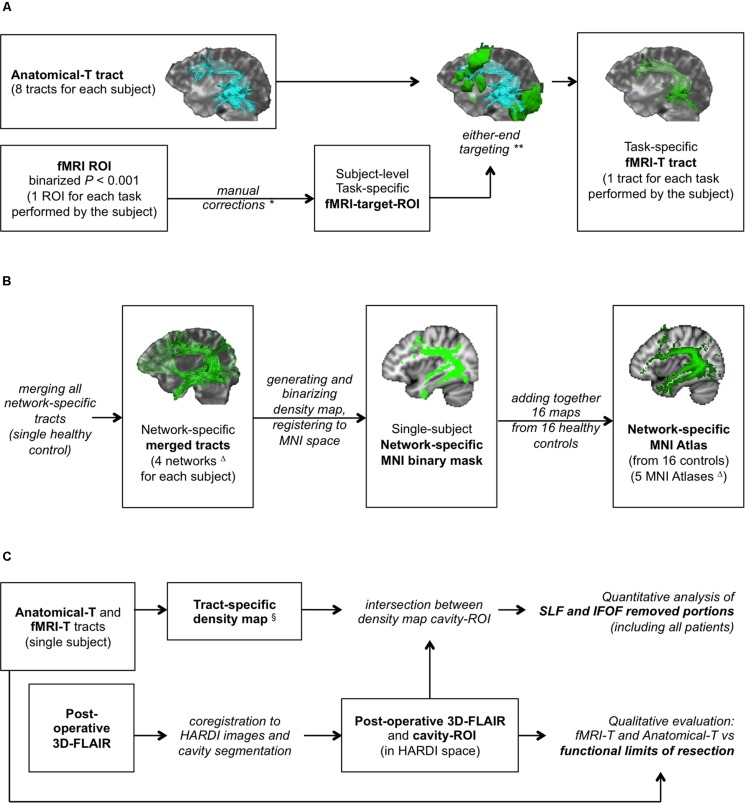
Study design. (A) fMRI-targeted Tractography (fMRI-T) tracts generation pipeline (applied to both healthy controls and patients); (B) flow-chart to generate healthy controls’ MNI Atlases (group study); (C) assessment method on patients’ cohort. *Only if stated rules apply. **In some cases this operation yielded no results. ΔFour subcortical networks (Anatomical, Picture Naming, Verbal Fluency, Auditory Verb Generation) were used to generate four MNI Atlases; an additional MNI Atlas (“any-task” Atlas) was obtained from the sum of all fMRI-T networks. §Only for AF-SLF and IFOF.